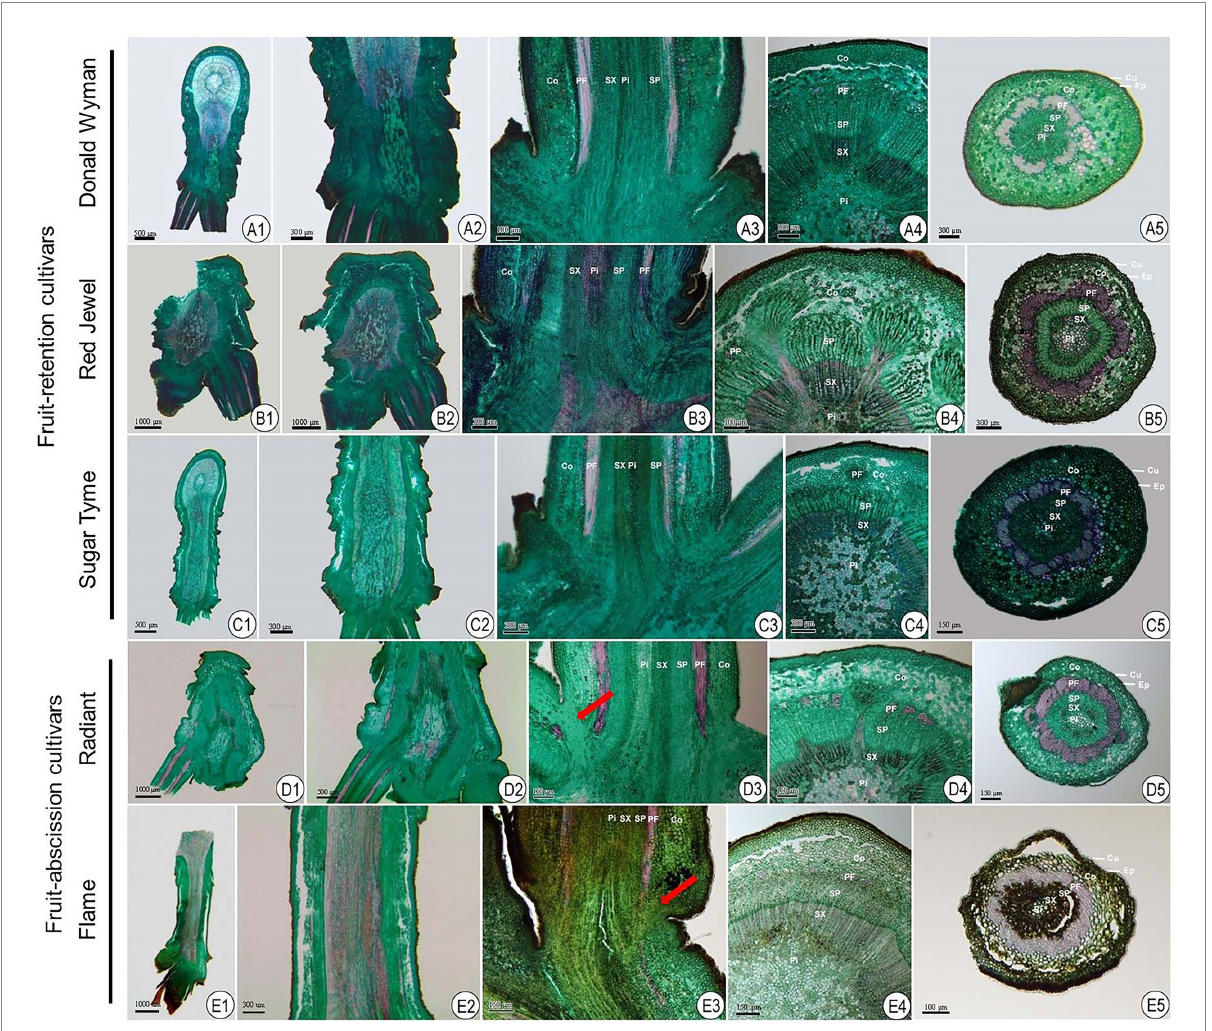
FIGURE 1 Anatomical observations of fruit AZ in fruit-retention and -abscission cultivars of ornamental crabapple. (A1–A5) “Donald Wyman”; (B1–B5) “Red Jewel”; (C1–C5) “Sugar Tyme”; (D1–D5) “Radiant”; (E1–E5) “Flame.” (A1–E1) and (A2–E2) longitudinal section of attached shoot and fruit pedicels; (A3–E3) longitudinal section of fruit pedicels; (A4–E4) and (A5–E5) transverse section of shoot and fruit pedicels, respectively. Cu, Cuticle; Ep, epidermal cells; Co, cortex; PF, phloem fiber; SP, secondary phloem; SX, secondary xylem; and Pi,